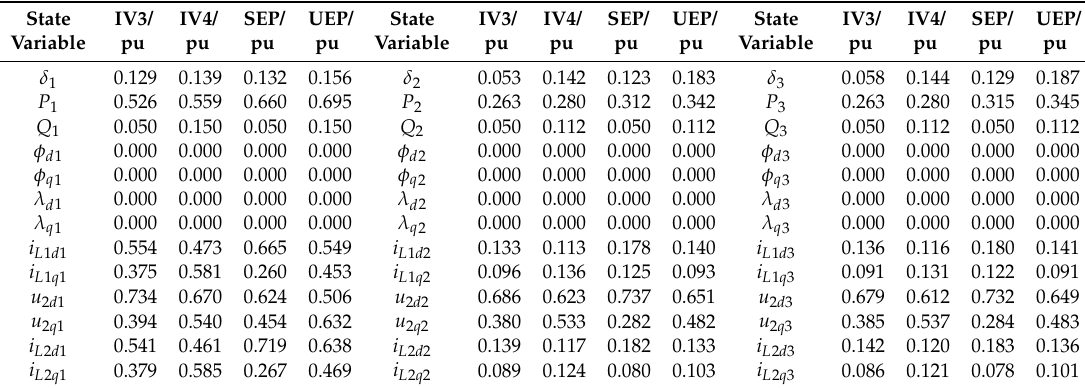
Figure 6. Structure diagram of the three-IIDG system. Table 6. Initial values and equilibrium points of system 2.